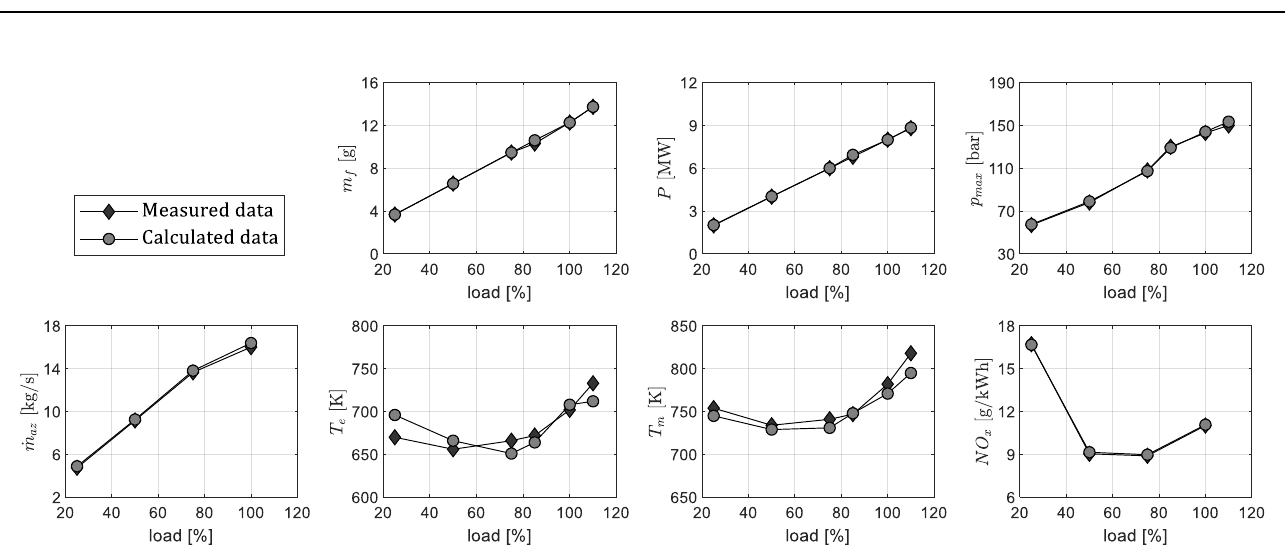
Figure 2. The performance of the dual-fuel engine running in liquid fuel mode with the SL model. The RMSE is the root mean square error. It is defined in Equation (19).